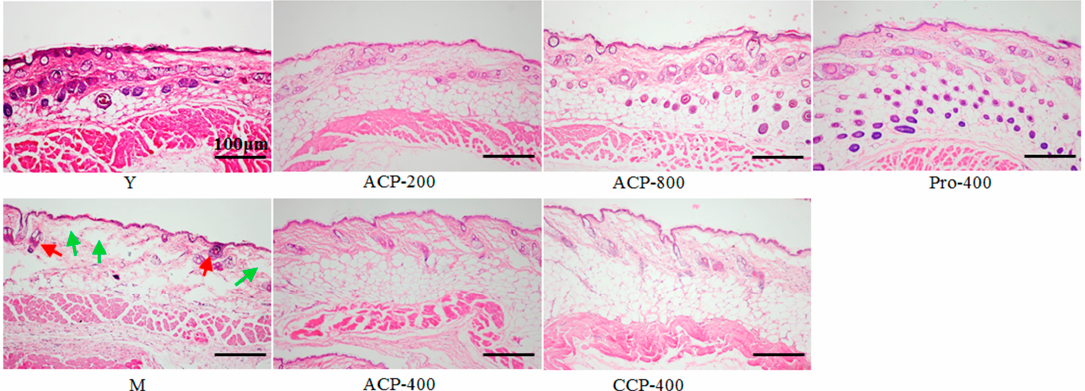
Figure 2. Representative images of haematoxylin–eosin (HE)-stained dorsal skin section from all groups, Y, young group; M, model group (old group); ACP, administrated by collagen peptides which was prepared by Alcalase; CCP, administrated by collagen peptides which was prepared by collagenase; Pro, proline group. 200, 400 and 800 represent administration doses of 200, 400 and 800 mg/kg body weight, respectively. Sebaceous glands and space in dermis tissue are shown as red arrows and green arrows, respectively. Scale bars, 100 μ m.